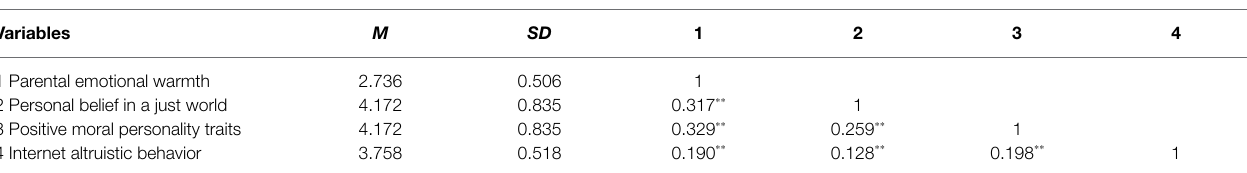
TABLE 1 | Correlation matrices in key variables ( N = 893).